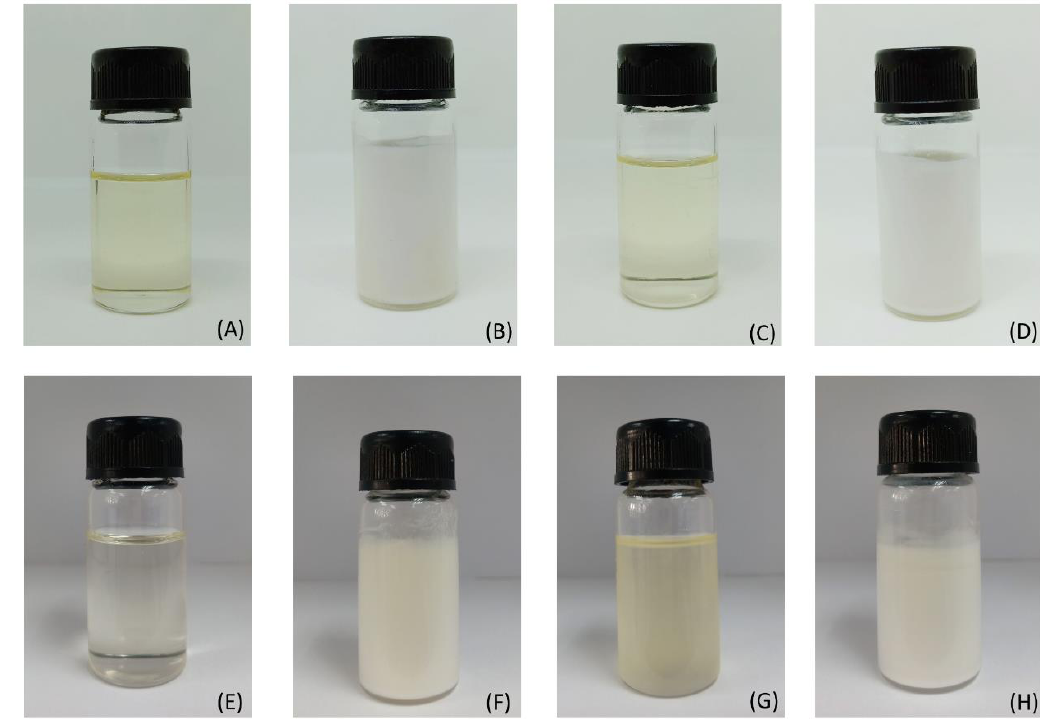
Figure 3. Photographs of the isopropyl myristate and oleic acid microemulsions system. The isopropyl myristate system is shown in the upper row and the oleic acid system is shown in the lower row; microemulsion without drug and hydrogel ( A , E ); sildenafil citrate dissolved in the microemulsion ( B , F ); microemulsion-loaded poloxamer 188 ( C , G ); and sildenafil citrate dissolved in the microemulsion and loaded with poloxamer 188 ( D , H ).